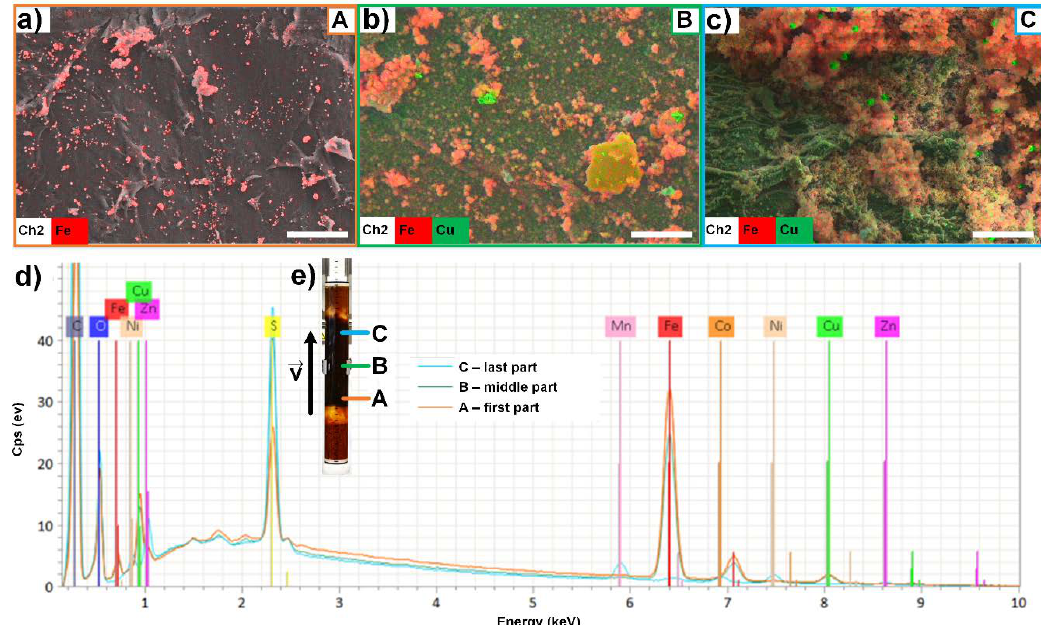
Figure 7. SEM-EDX results of selected samples from the column after the adsorption process. SEM-EDX images of ( a ) first part ( A ) of the column, ( b ) the middle part ( B ) of the column, and ( c ) last part ( C ) of the column (beginning, middle and end of the column in the direction of flow). Scale bar shows 20 µ m. ( d ) EDX spectra of the SEM-EDX images in ( a – c,e ) Image of the column divided into the first part A , the middle part B , and the last part C